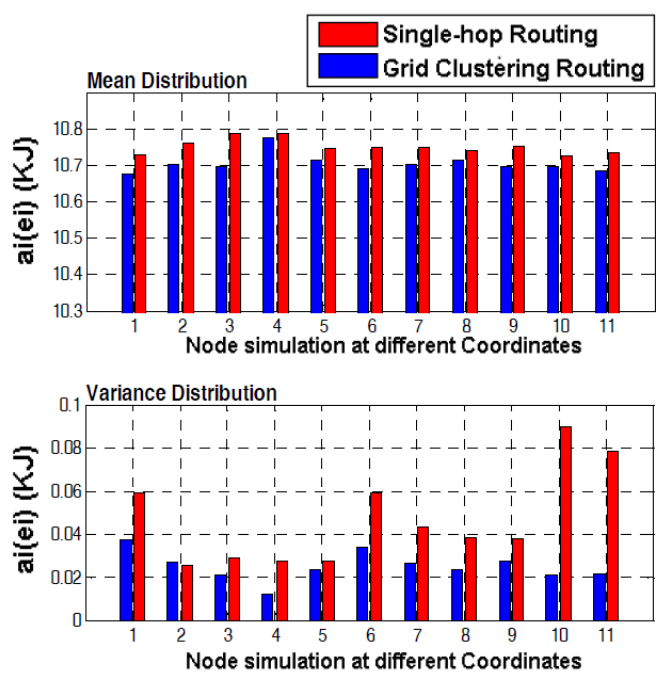
Figure 11. Minimal energy of each node.